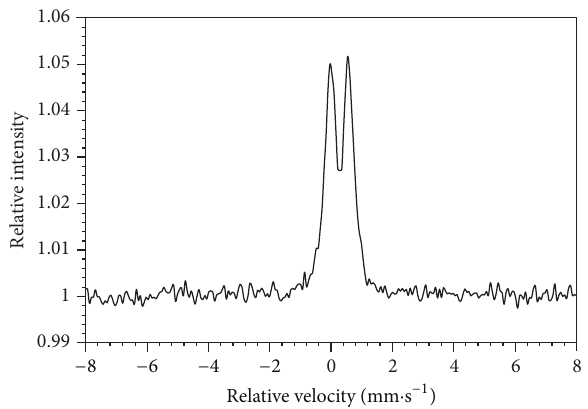
Figure 3: M¨ossbauer spectrum of corrosion products on specimen exposed for 9 months at Cubat ˜